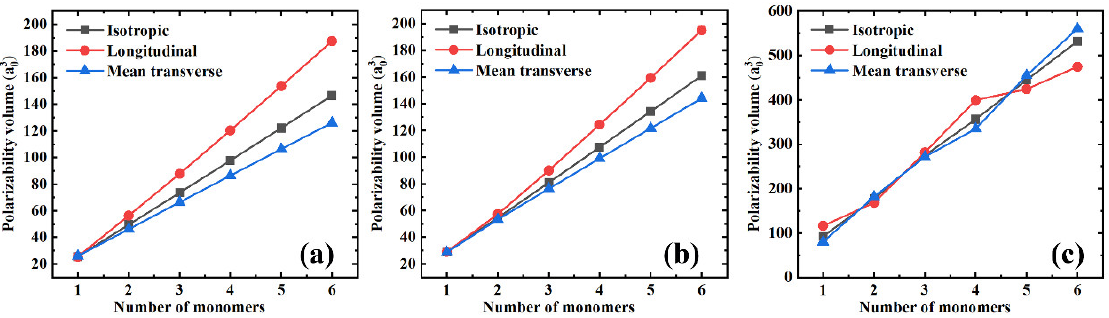
Figure 2. The isotropic, longitudinal, and mean transverse polarizability components as a function of the number of monomers for different polymer materials. ( a ) PE; ( b ) PTFE; and ( c ) PS.